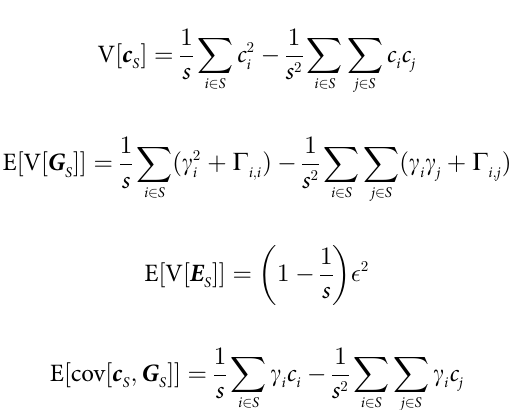
BM (top panel) and OU (bottom panel) models, as a function of sample size. We randomly sampled 40 subsets of the full dataset (subtype B only, N = 1581) and inferred maximum likeli- bility and gray lines show the bootstrap confidence intervals. The dashed line represents the